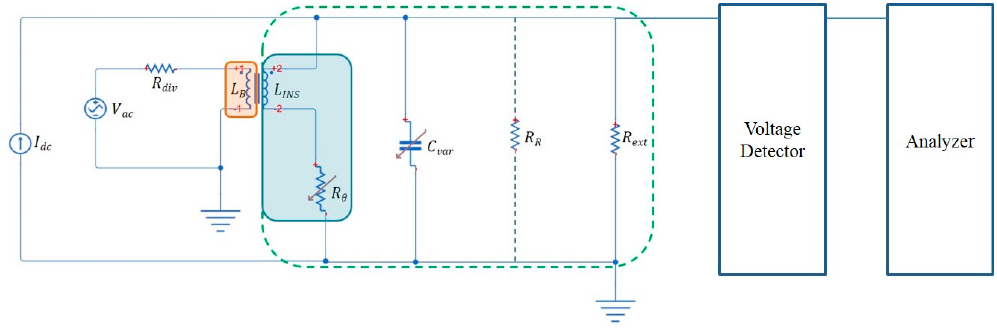
Figure 2. Equivalent circuit of the proposed quench detection method.